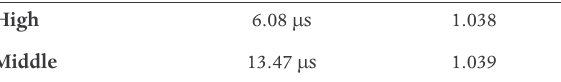
Table 2. Time and amplitude shift factors calculated for the INGV